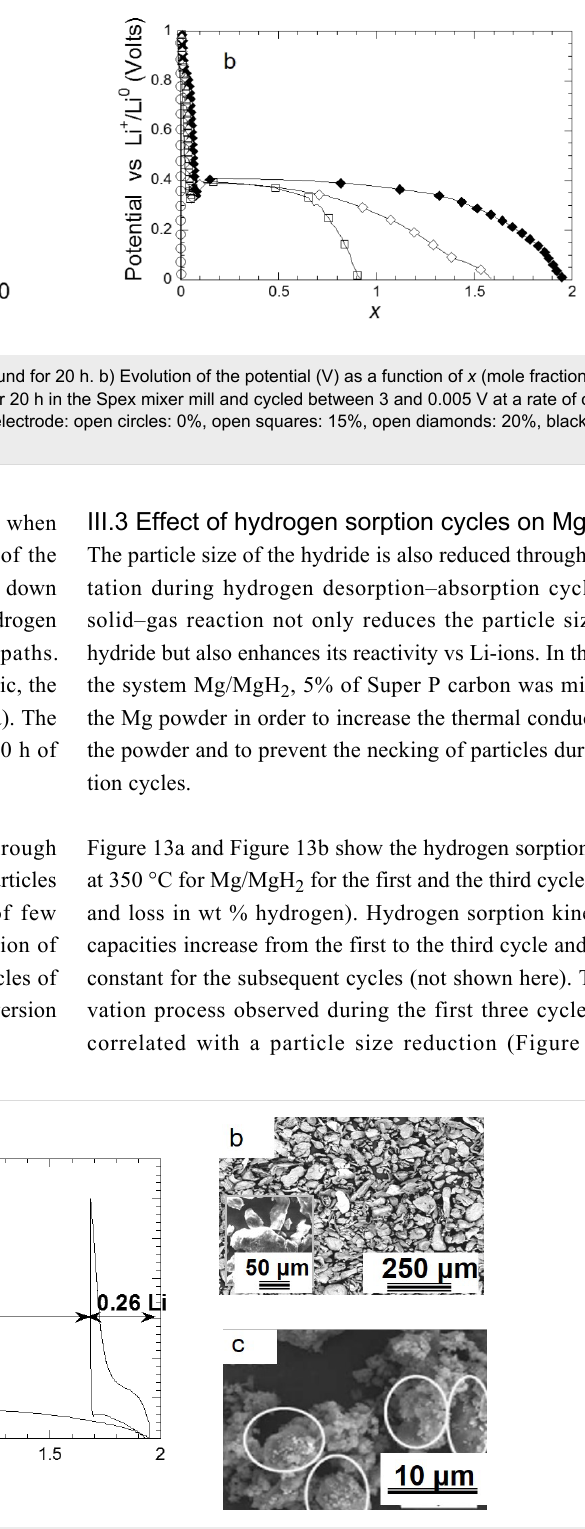
Figure 12: a) Evolution of the potential (V) as a function of x (mole fraction of Li) for a MgH 2 electrode prepared with commercial hydride, ground 30 h in a Spex mixer mill and cycled between 3 and 0.005 V at a rate of one equivalent of lithium in 100 h. b) SEM image of a MgH 2 commercial